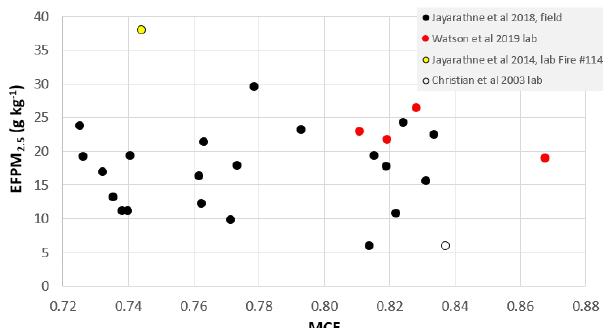
Figure 7. Gravimetric determination of EFPM 2 . 5 versus MCE for tropical peat fires. See text for